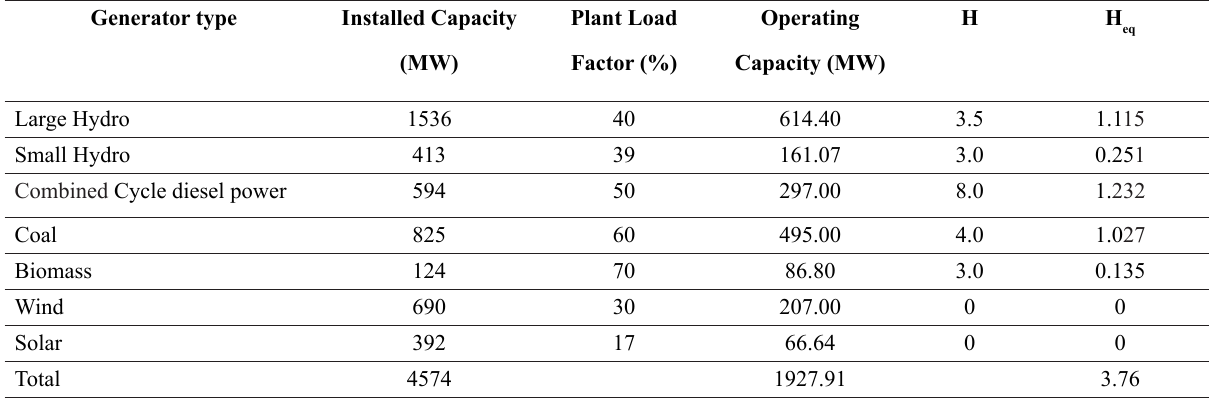
Table 1: Equivalent inertia constants for the year 2020